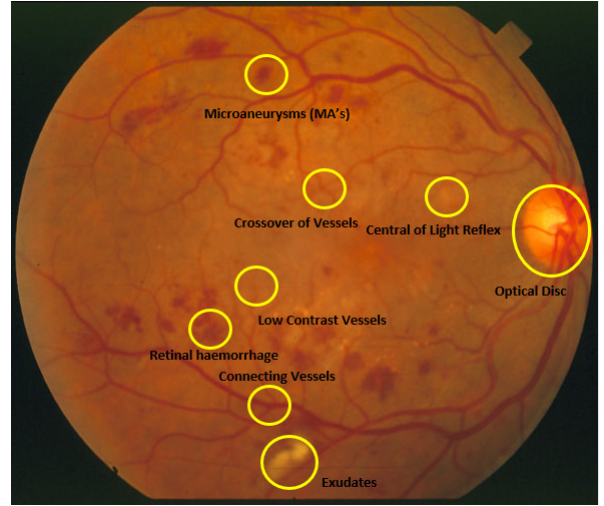
Figure 2. Abnormalities associated with Retinal Fundus